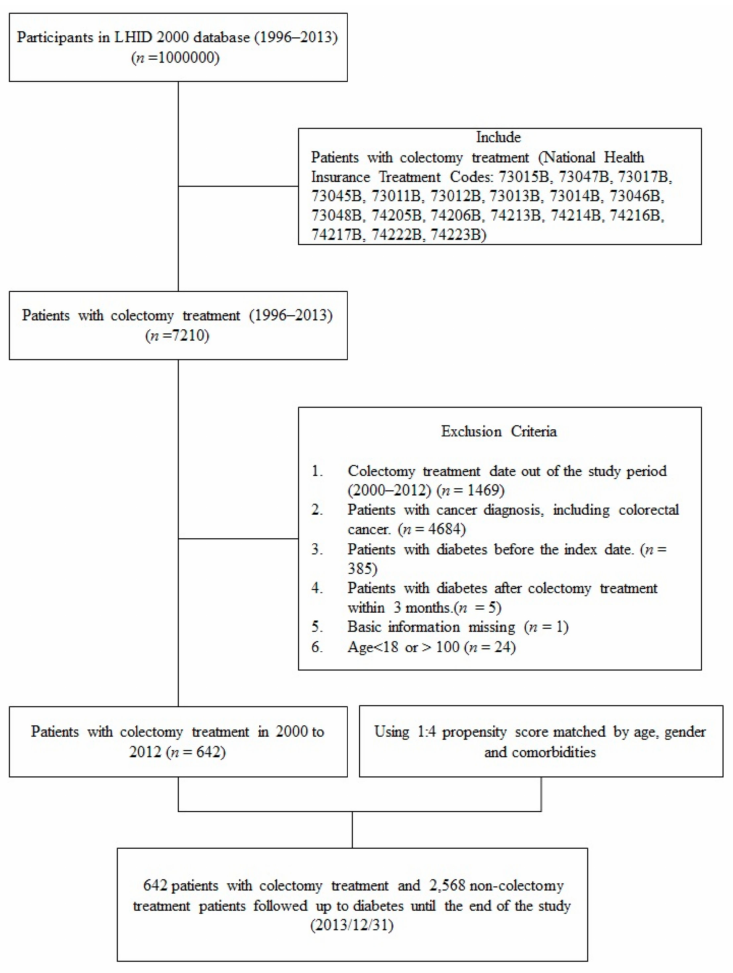
Figure 1. Flow chart of study cohort collection from the longitudinal database (LHID). Non-colectomy patients were randomly selected from patients in the LHID 2000 who had no history of colorectal cancer and colectomy. We did not choose patients who underwent abdominal surgery without colectomy to form the control group